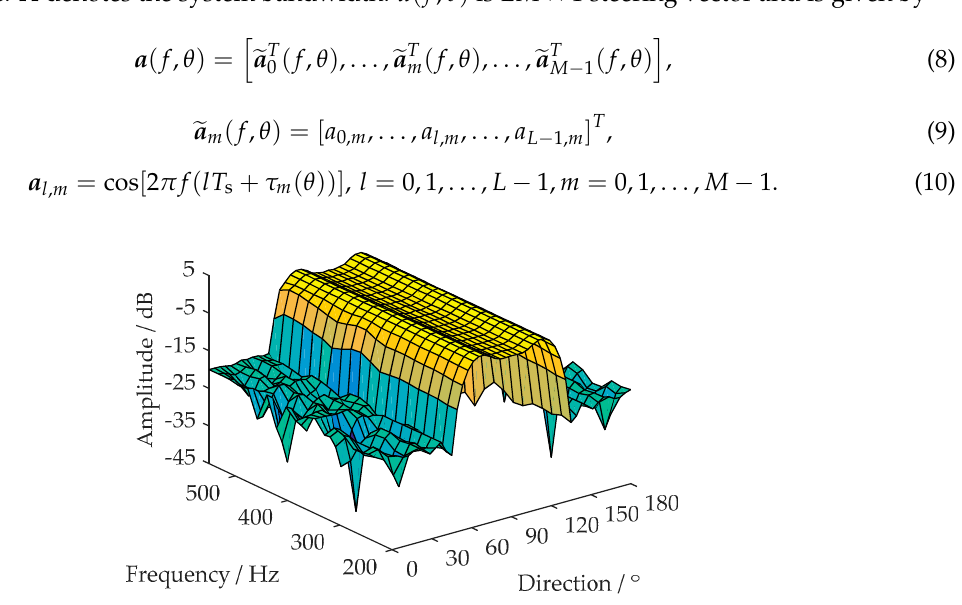
Figure 6. Magnitude response of the fixed weight vector W